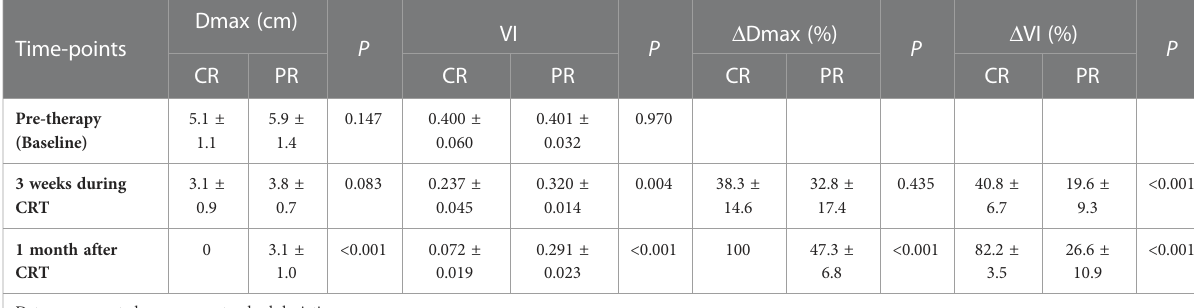
TABLE 2 The mean Dmax and VI value of the tumor in the complete and partial responders at each time point. Dmax Time-points